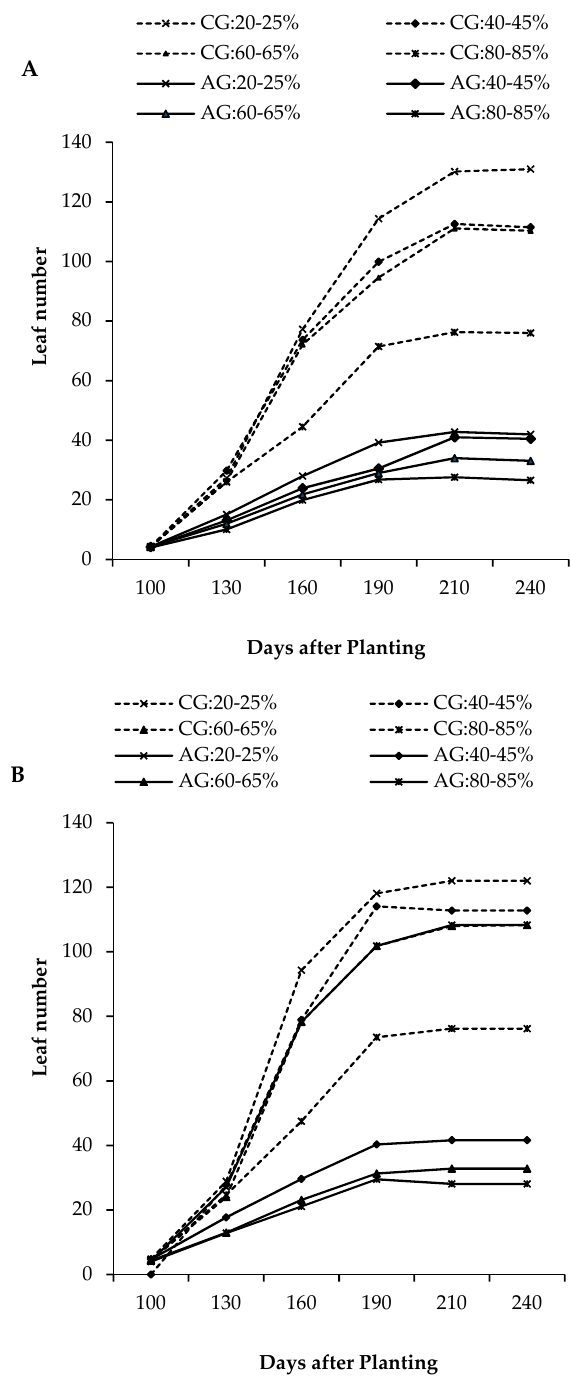
Figure 3. Number of leaves per plant of two ginger species in response to different water regimes during the ( A ) 2015/2016 and ( B ) 2016/2017 cropping seasons. Where: CG: Commercial ginger; AG: African ginger; Vertical bars represent least significant difference (P ≤ 0.05).